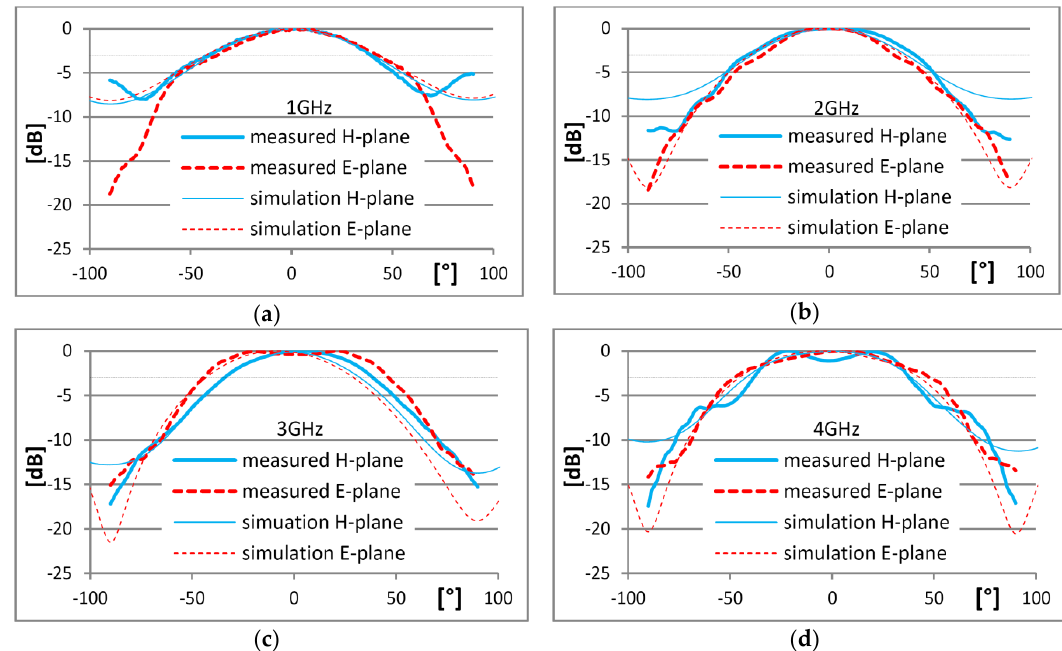
Figure 10. The antenna radiation patterns with a CPWG excitation at frequencies: ( a ) 1 GHz, ( b ) 2 GHz, ( c ) 3 GHz, and ( d ) 4 GHz.